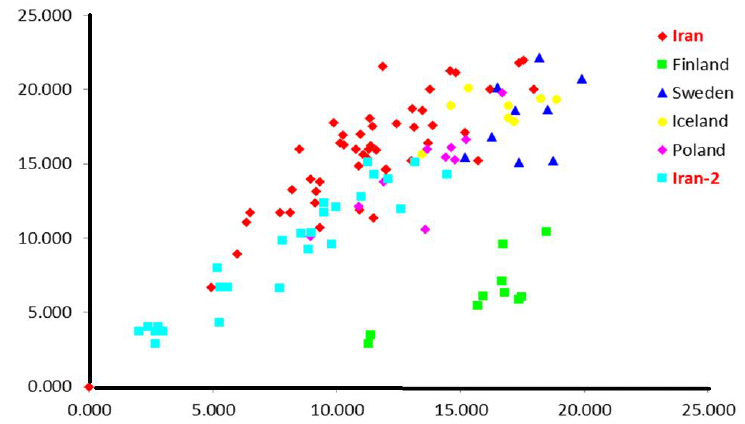
Fig. 2. Assignment percentage of individuals based on structure analysis per each